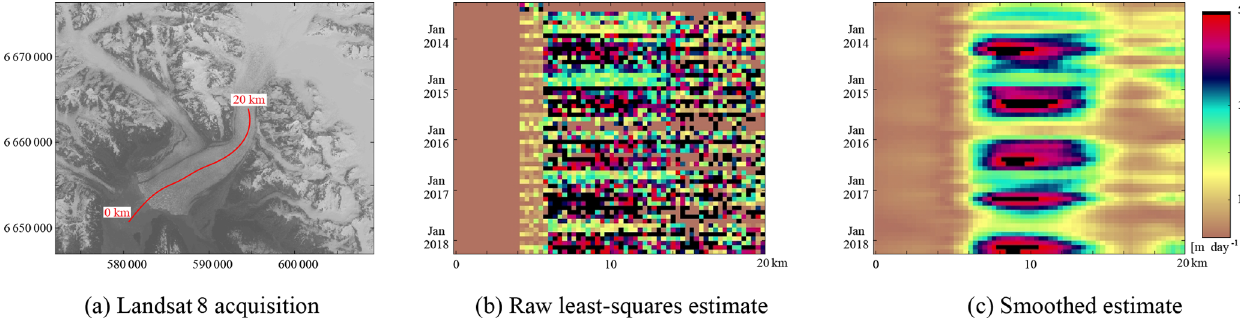
Figure B3. (a) Landsat 8 acquisition on 5 September 2013 over Hubbard Glacier; in red is the centerline used for the sampling which is plotted in panels (b) and (c) . (b) Velocity estimates using the data of displacements that had consensus during the voting step. (c) Smoothed estimate of velocity evolution over time, using spatial and temporal data and assisted by an off-glacier